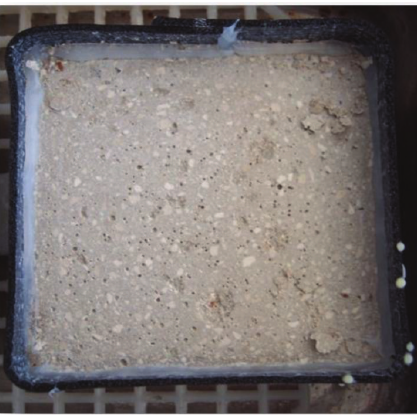
Figure 15: Freeze-thaw resistance: mix TQ.